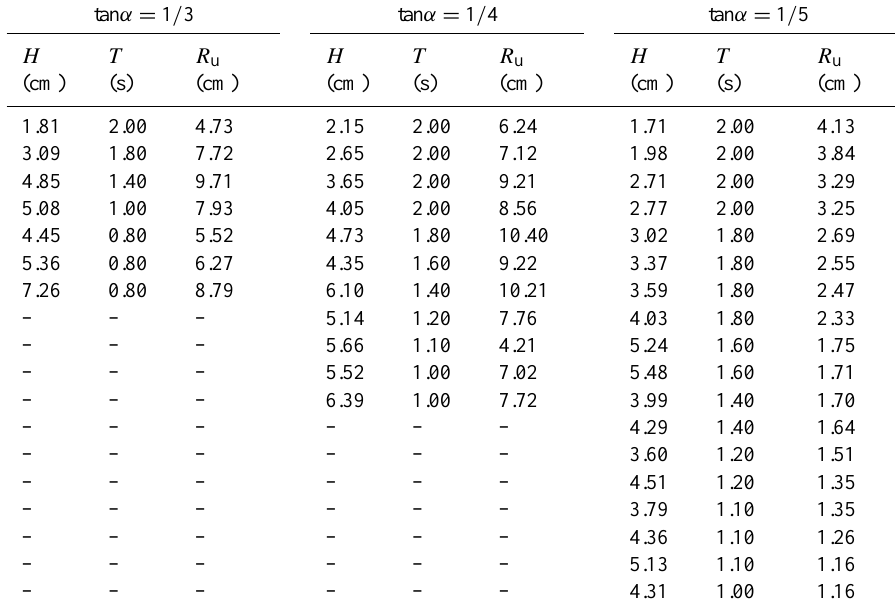
Table 2. Laboratory experimental conditions of wave run-up.